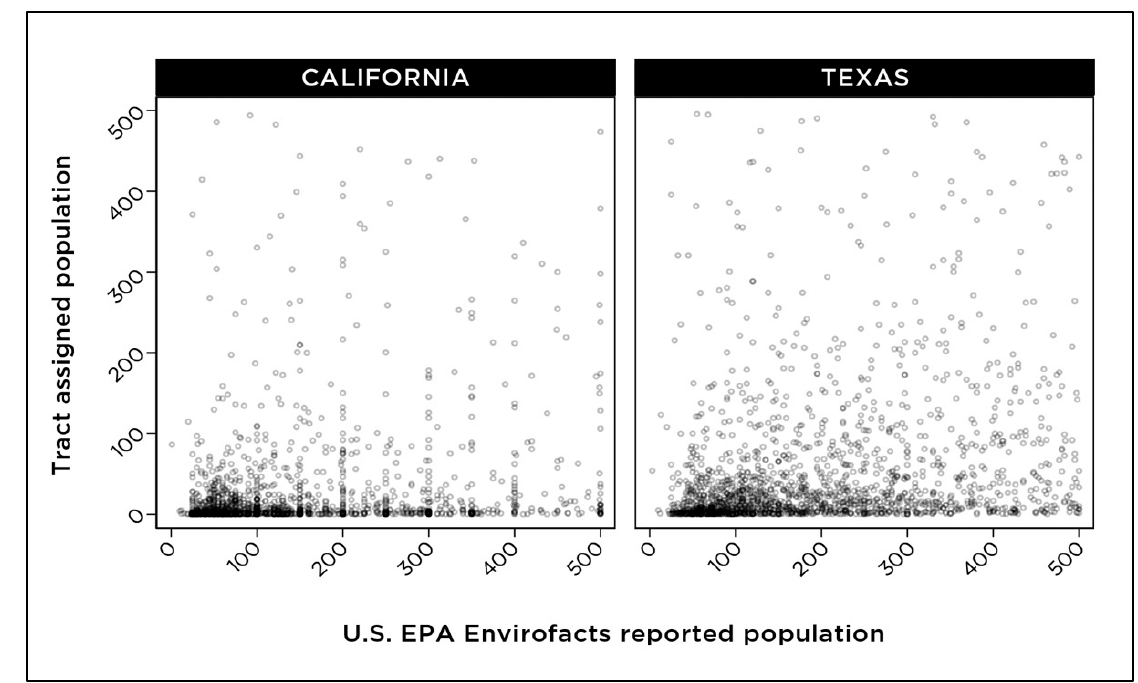
Figure 5. Tract ‐ assigned population estimates for community water systems that, according to the U.S. EPA Envirofacts, serve populations of 500 people or less.